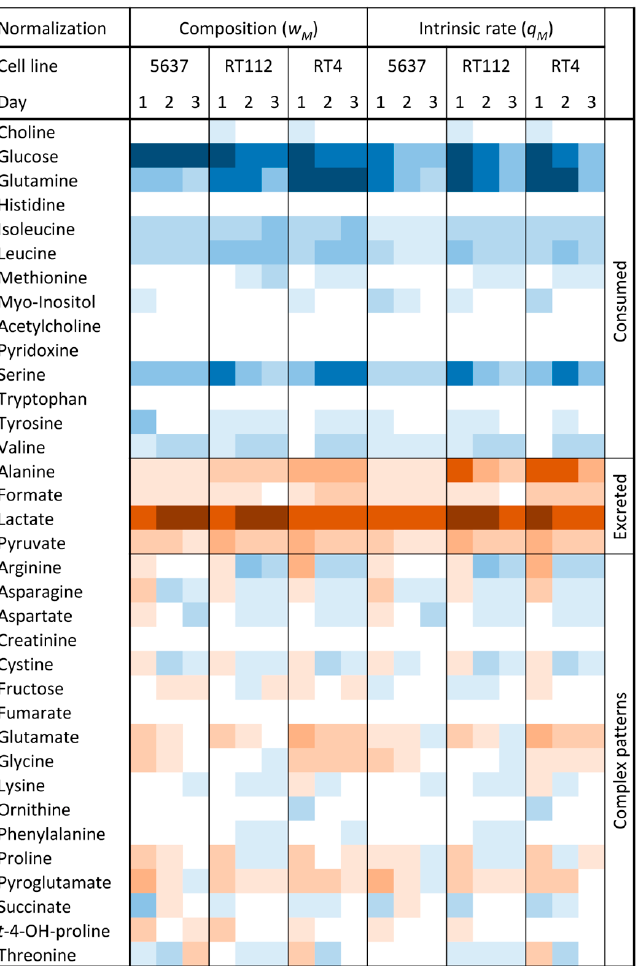
Figure 1. Heatmap showing the daily variations in metabolite concentrations for the three urothelial bladder cancer cell lines (UBCcls). Variations normalized using both cell growth or total composition are shown. Light blue and brown colors are used for consumption and excretion, respectively. Variations increase from the light to the dark colors.